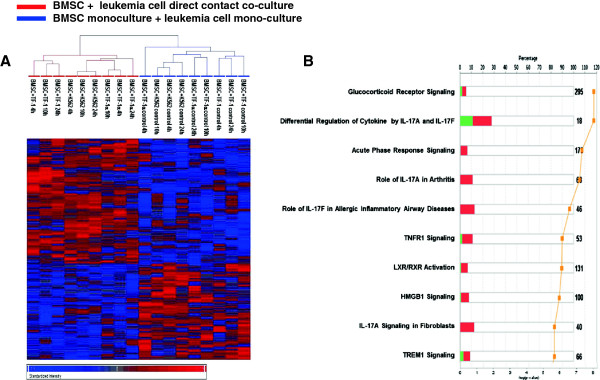
Gene expression analysis of BMSCs co-cultured in direct contact with leukemia cells shows changes in IL-17 signaling-related genes. BMSCs from three healthy donors were co-cultured in direct contact with the three different leukemia cell lines (TF-1, TF-1α and K562). The cells were harvested at 4 h, 10 h and 24 h and total RNA were extracted. The total RNA from BMSC mono-cultures was mixed with the total RNA from TF-1, TF-1α or K562 cell mono-cultures and the resulting three mixed total RNA samples were used as a “mono-culture” control and were subjected to gene expression analysis. The RNA from BMSCs and leukemia cells co-cultured in direct contact was extracted and gene expression was analyzed. Analysis with Partek Genomic Suite revealed that 544 genes that were differently expressed between the BMSCs and leukemia cell direct contact co-culture samples and the mono-culture controls (p-value < 0.05, FDR < 0.01). Panel A; Hierarchical clustering analysis of 544 differentially expressed genes in BMSCs and leukemia cell direct contact co-cultre samples compared with the mono-cultures (control) using Partek Genomic Suite program (ANOVA test with unadjusted p-value < 0.05). The displayed colors represent the fold changes where shades of red and blue indicate up- and down-regulation respectively. The color key for the sample labels is on the top left. Panel B. Ingenuity Pathway Analysis (IPA) of the 544 differentially expressed genes. Numerical symbols at the right side of each bar indicate the total number of genes composing the pathway. The bars indicate the percentage of up- (red bar) and down-regulated (green bar) genes in each pathway, while the orange line indicates minus-log transformed p-value. The top 10 canonical pathways are shown.